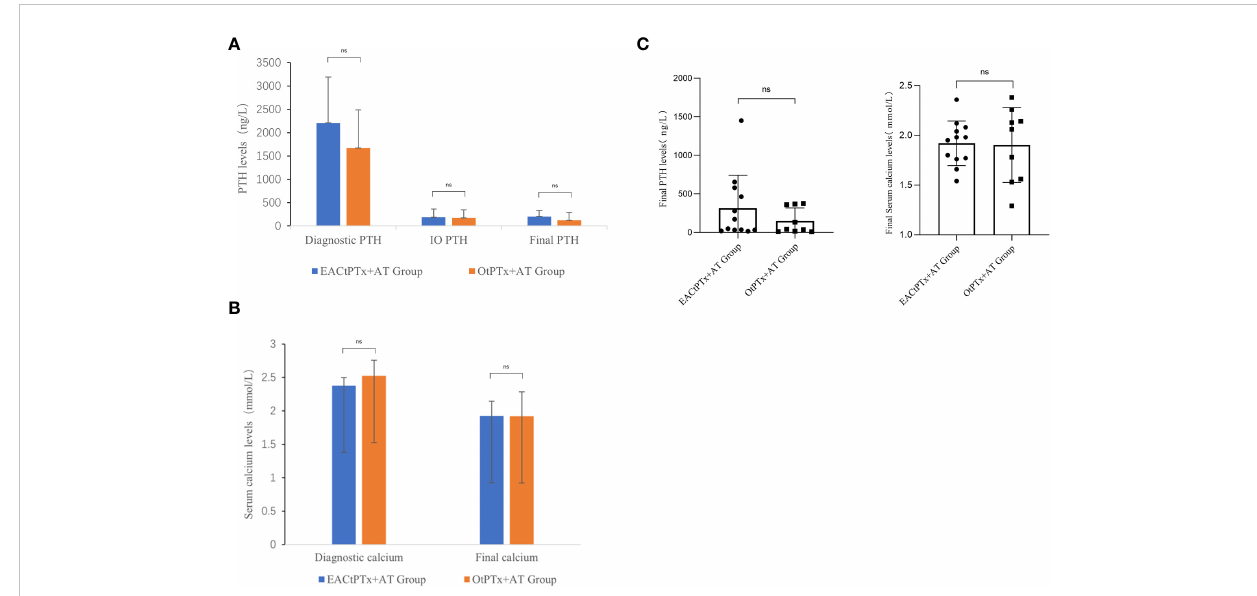
FIGURE 6 The results of PTH and serum calcium levels in two groups. (A) Parathyroid hormone (PTH) levels:Diagnostic PTH, IO PTH, fi nal PTH. (B) Serum calcium levels:Diagnostic calcium, fi nal calcium. (C) Comparison of postoperative PTH and Serum calcium between the two groups.